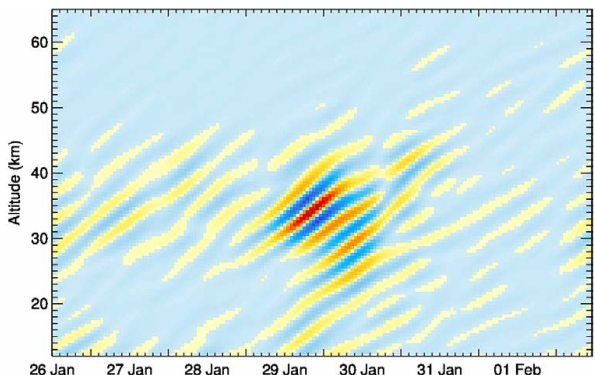
Figure 10. Downward-propagating waves with λ z = 4 . 7–6.2km and c Pz ≈ 0 . 1ms − 1 occurring during 29 to 30 January 2016 as re- constructed by wavelet